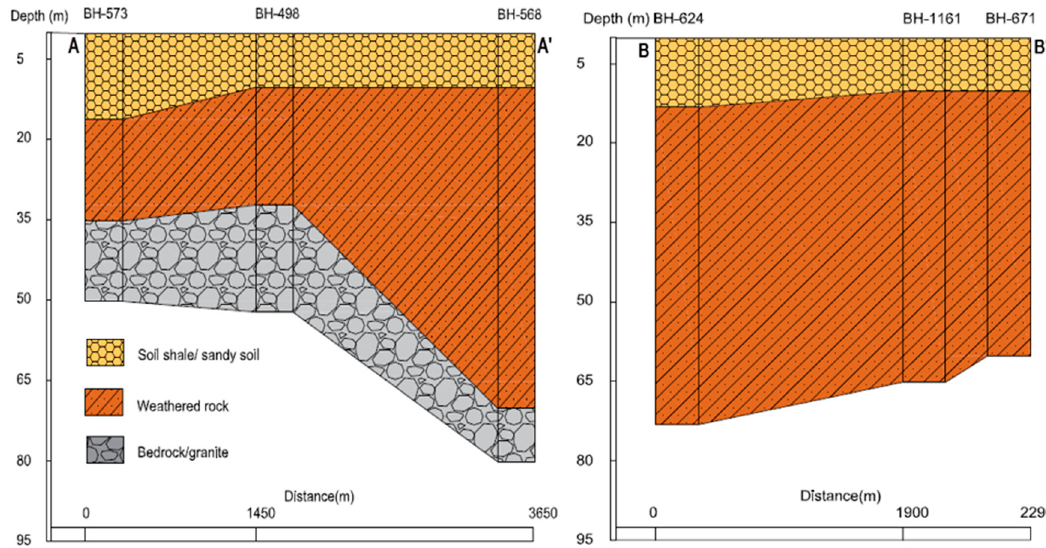
Figure 3. Subsurface stratigraphy of Kamala along Line AA’ and BB’.